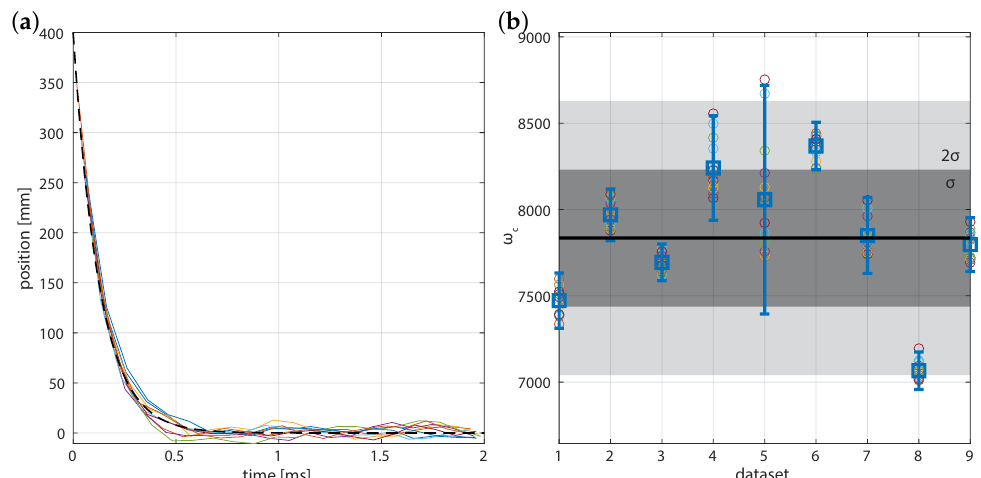
Figure 6. ( a ) Trajectory of in-falling 2µm particle meeting the criteria that the initial position, 1 ≥ x 0 /400nm > 1/2.5 to put the data in the high signal-to-noise region. The time traces have been offset in time to a projected 400nm starting position based on the first measured point. The dashed line is the fall for a particle at the mean angular trap frequency. ( b ) Calculated trap stiffness for several trapping events meeting the criteria for ( a ). The dark and light gray shaded regions respectively represents ± σ and ± 2 σ of the determined angular trap frequency around the